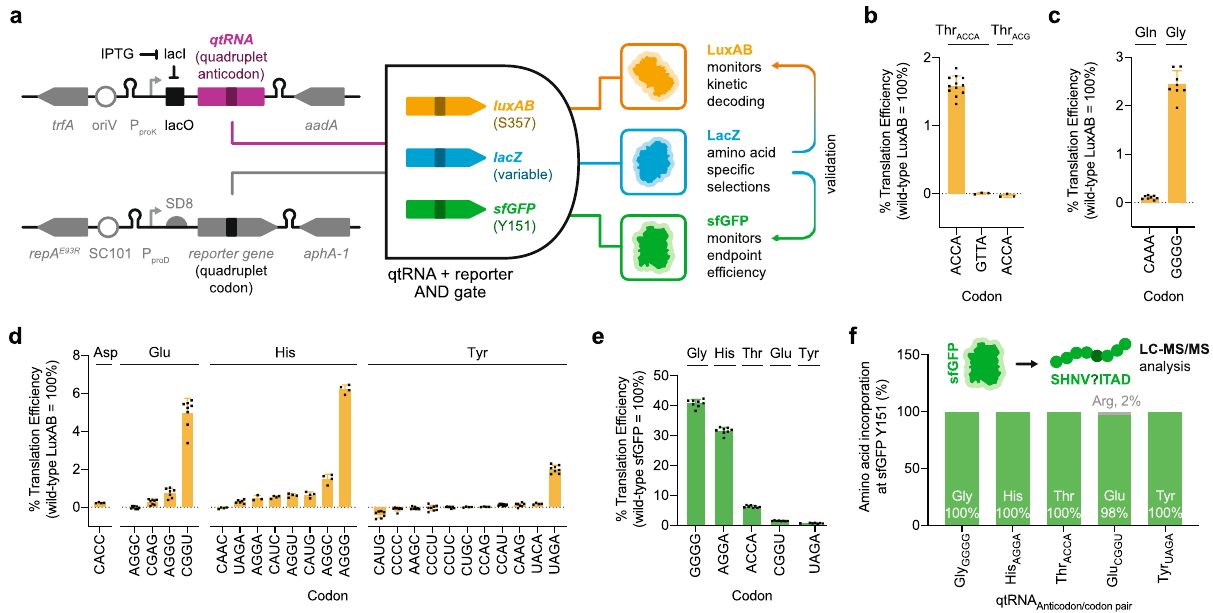
Fig. 1 Discovery and quanti fi cation of selection derived qtRNAs. a Schematic representation of cellular reporter assays. Suppressed positions in the reporter proteins are shown in parentheses. In all cases, reporter protein translation prematurely terminates in the absence of a functional qtRNA due to a stop codon generated downstream of the quadruplet codon. Conversely, a functional qtRNA affects quadruplet codon suppression, yielding a full-length protein. b Validation of the luciferase reporter for quadruplet codon suppression. The previously described qtRNA Thr ACCA 25 ( n = 12 biologically independent samples) selectively decodes the cognate quadruplet codon, whereas a codon/anticodon mismatch or native triplet tRNA yields no luminescence using the quadruplet codon at residue S357 in LuxAB. Data for the remaining combinations represents the mean and standard deviation of three biologically independent samples. c Decoding ef fi ciency of previously described qtRNAs, qtRNA Gln CAAA 27 , and qtRNA Gly GGGG 85 ( n = 8 biologically independent samples). d The LacZ selection pipeline yielded functional qtRNAs for aspartate ( n = 4 biologically independent samples), glutamate (Glu n = 8 except for Glu-AGGG n = 7), histidine (His n = 4 except for His-AGGA n = 3 and His-UAGA n = 6), and tyrosine (Tyr n = 7 except for Tyr- CCCC, CCCU, CCAU, and UAGA n = 8 and Tyr-CUGC, CCAG, and UACA n = 4), which were assayed using the luciferase reporter. e Several LacZ selection-derived qtRNAs showed robust suppression of the cognate quadruplet codon at the permissive residue Y151 in sfGFP ( n = 8 biologically independent samples, except for Tyr-UAGA n = 7). f The sfGFP reporter was used to quantify amino acid incorporation at position Y151 via mass spectrometry. Comprehensive peptide fragmentation spectra are reported in Supplementary Fig. 3 and summary LC-MS/MS results are reported in Supplementary Table 8. In all cases, reporter data is normalized to an otherwise wild-type reporter protein and color-coded by the used reporter. Unless otherwise noted, all qtRNAs were assayed against their cognate quadruplet codon incorporated at residue S357 in LuxAB or Y151 in sfGFP. Data represent the mean and standard deviation as